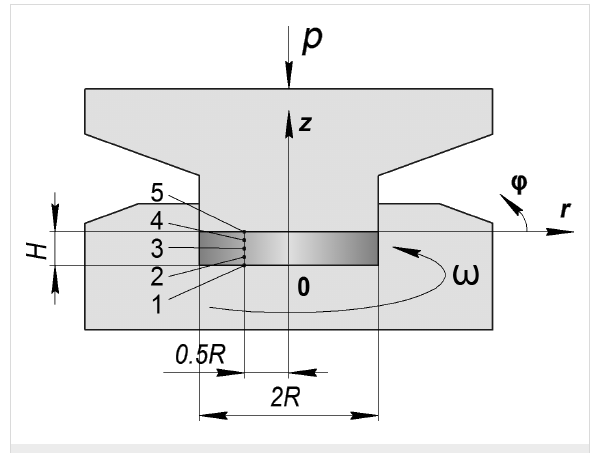
Figure 1: Schematic geometry of the constrained HPT process (the notation is defined in the main